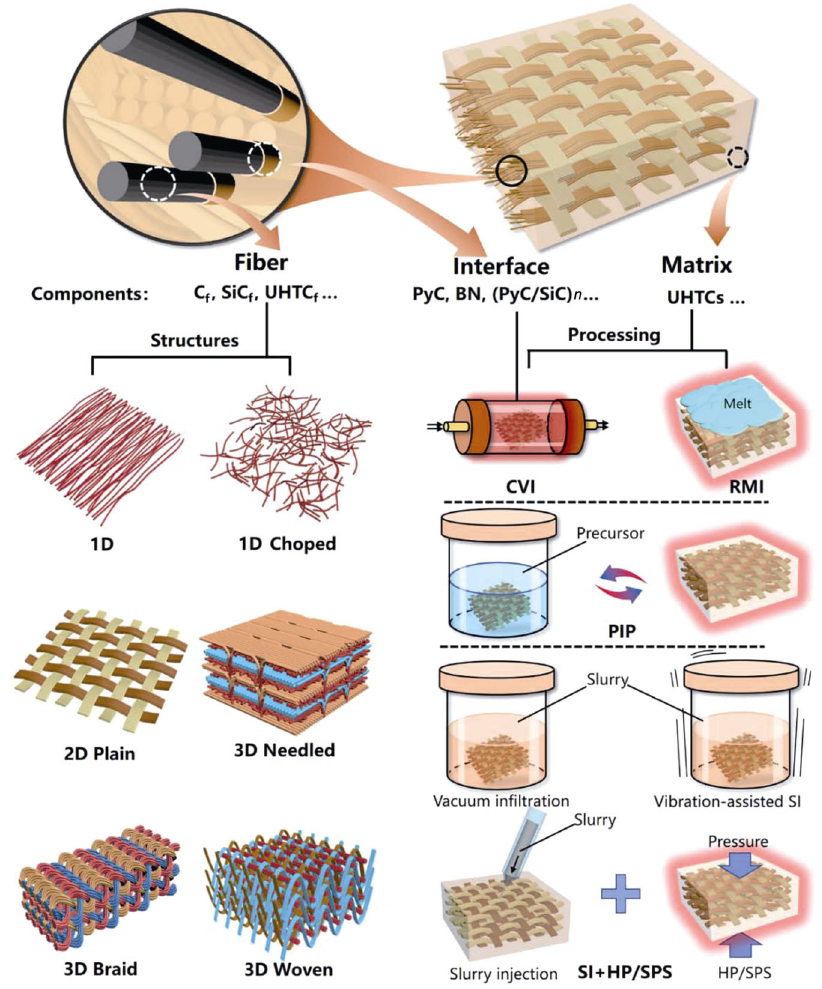
Fig. 14 Schematic diagram of the components and processing of